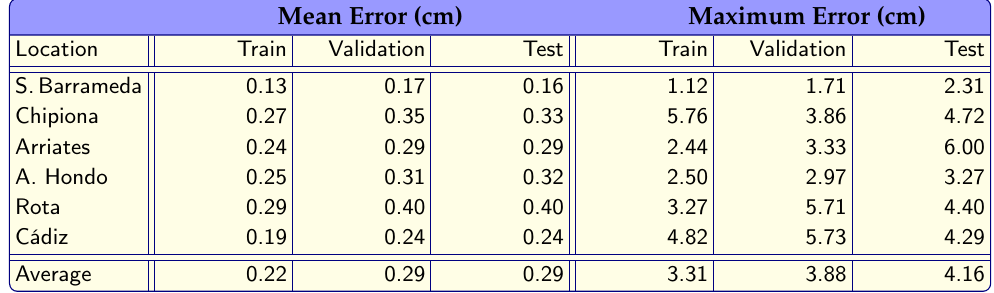
Table 13. Mean and maximum absolute errors with the ensemble model 17 for the predicted maxi- mum